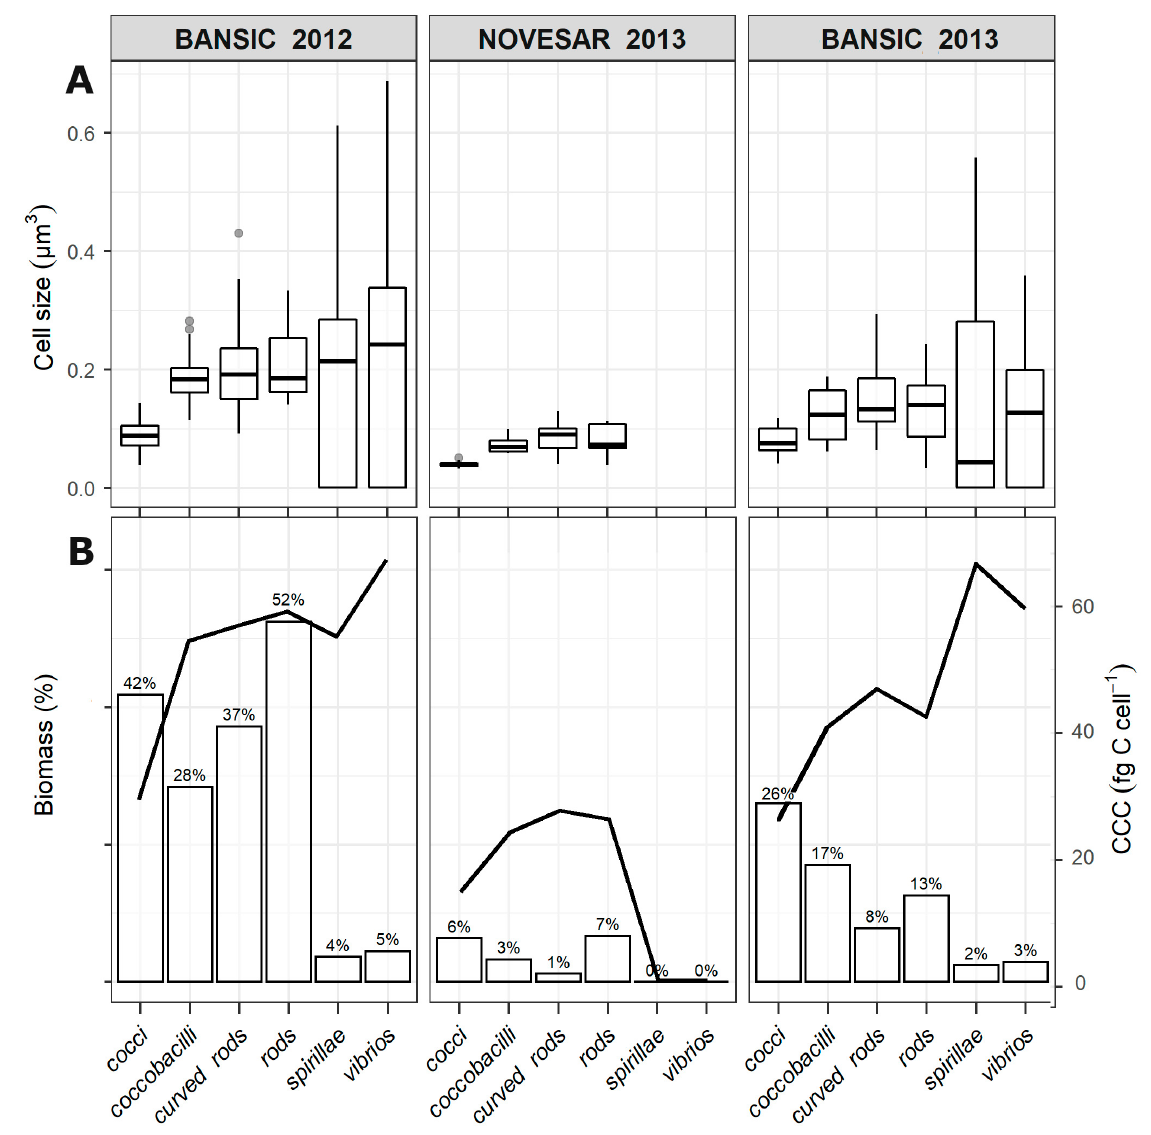
The cell VOL, CCC and biomass of each morphotype are reported in Figure 3A and 3B, respectively.